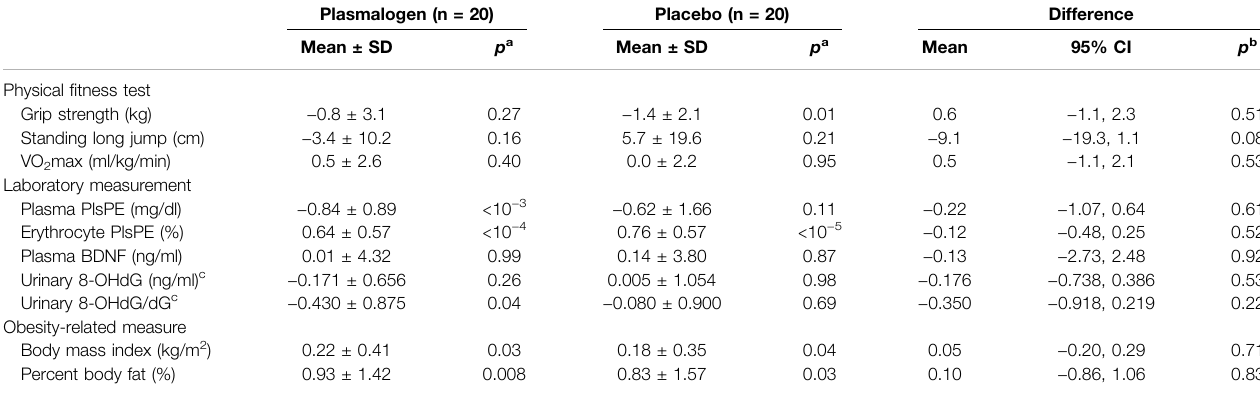
TABLE 6 | Changes in physical fi tness, laboratory measurements, and obesity-related measures at 2 and 4 weeks from baseline. Plasmalogen (n =